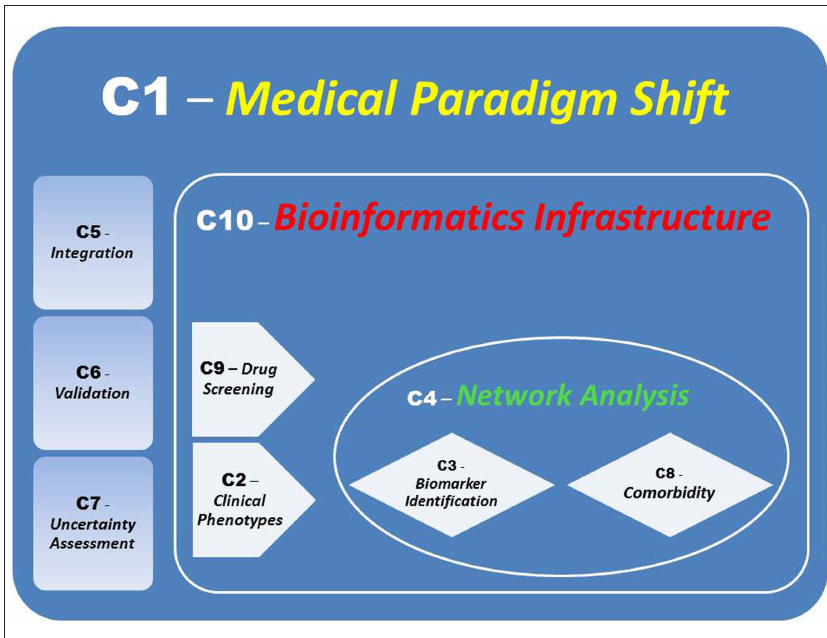
Figure 1 | Links between Challenges. A modularization of the Bioinformatics Infrastructure embedding integratively and significantly validated inferences will lead to a Systems Medicine